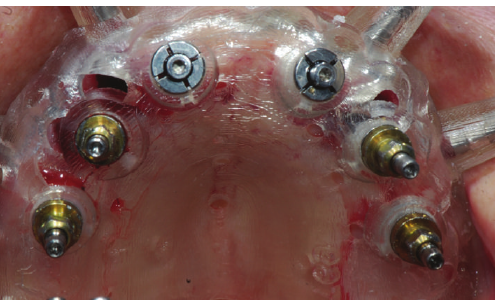
Figure 3: Guided flapless implant insertion in healed sites and fresh extraction sockets.